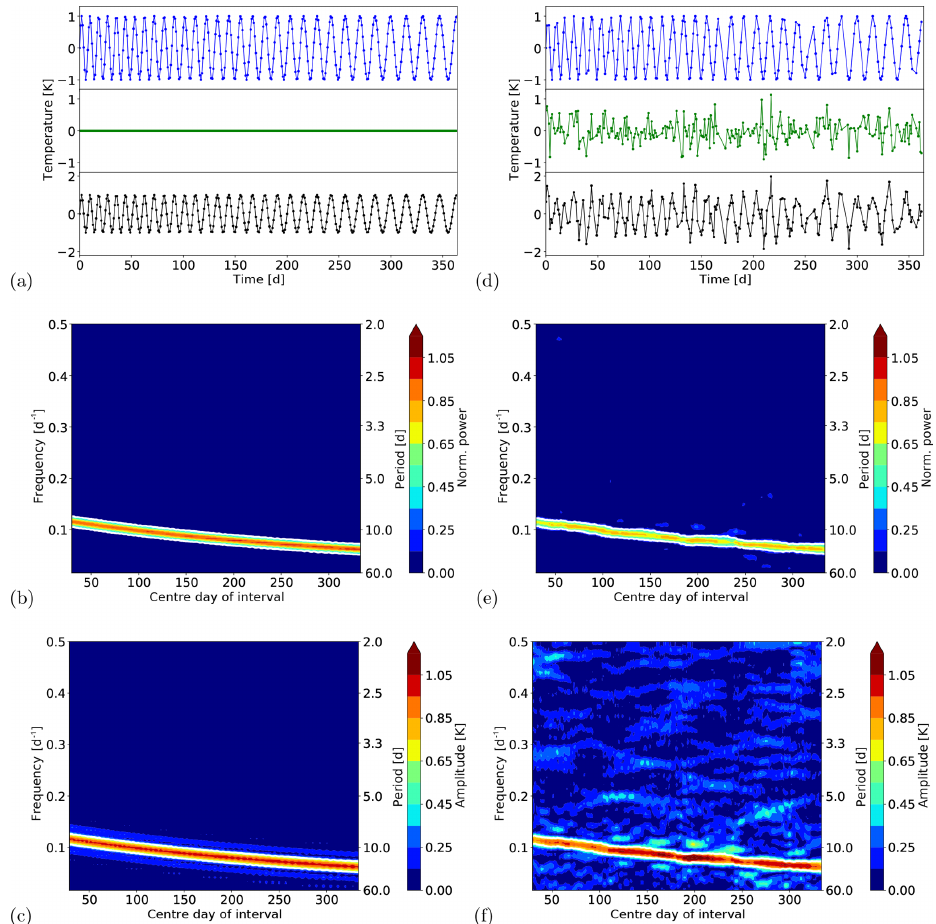
Figure 5. (a) Time series of a periodic signal with increasing period. The upper panel shows the signal, the middle panel the noise, and the lower panel the sum of both. (b, c) Results for the normalised power and amplitude. The results are displayed at the centre day of the corresponding time window. The length of the time window was 60d. The white contours mark the significant results. (d–f) Same as for (a–c) with additional noise added to the time series and data gaps.